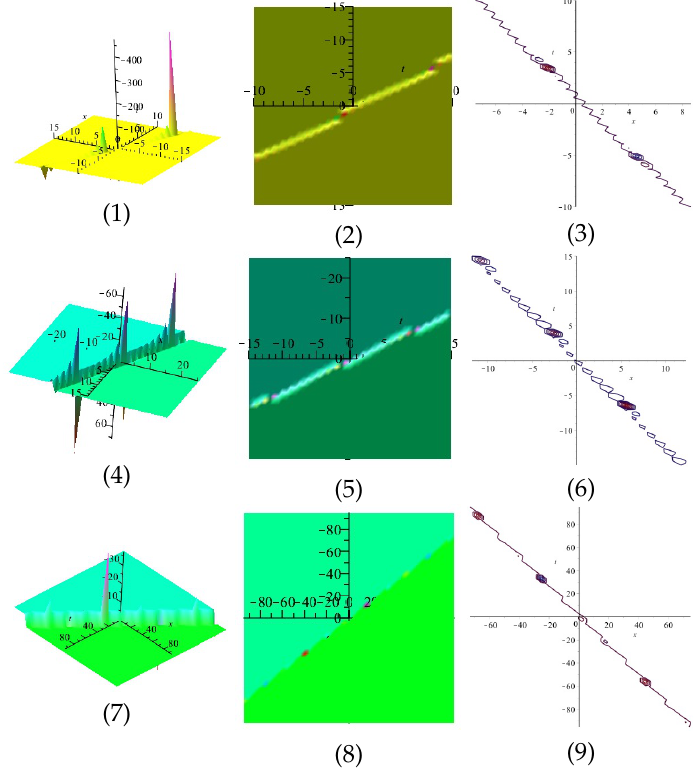
Figure 2. The 3D and 2D with the diagram of Equation (40), in three different